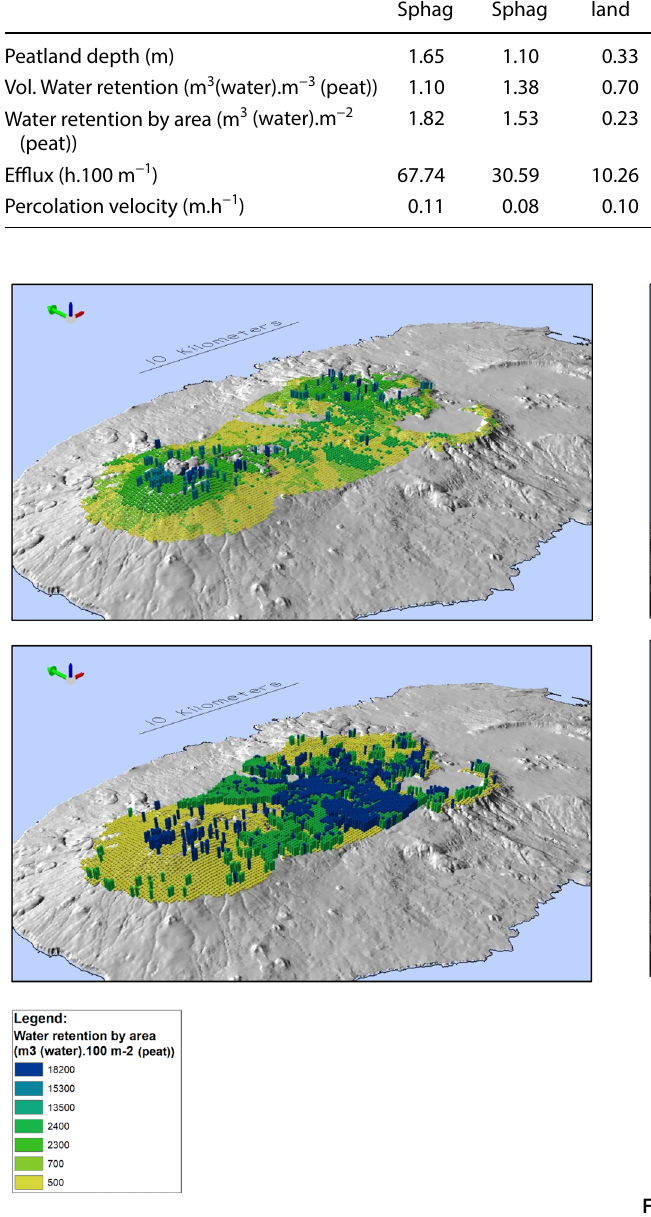
Fig. 9 Tridimensional representation of water retention by area (m3 (water).100 m −2 (peat)), actual (top) and potential (bottom), for Terceira Island (Digital Model elevation is proportional to the bidi- mensional scale)